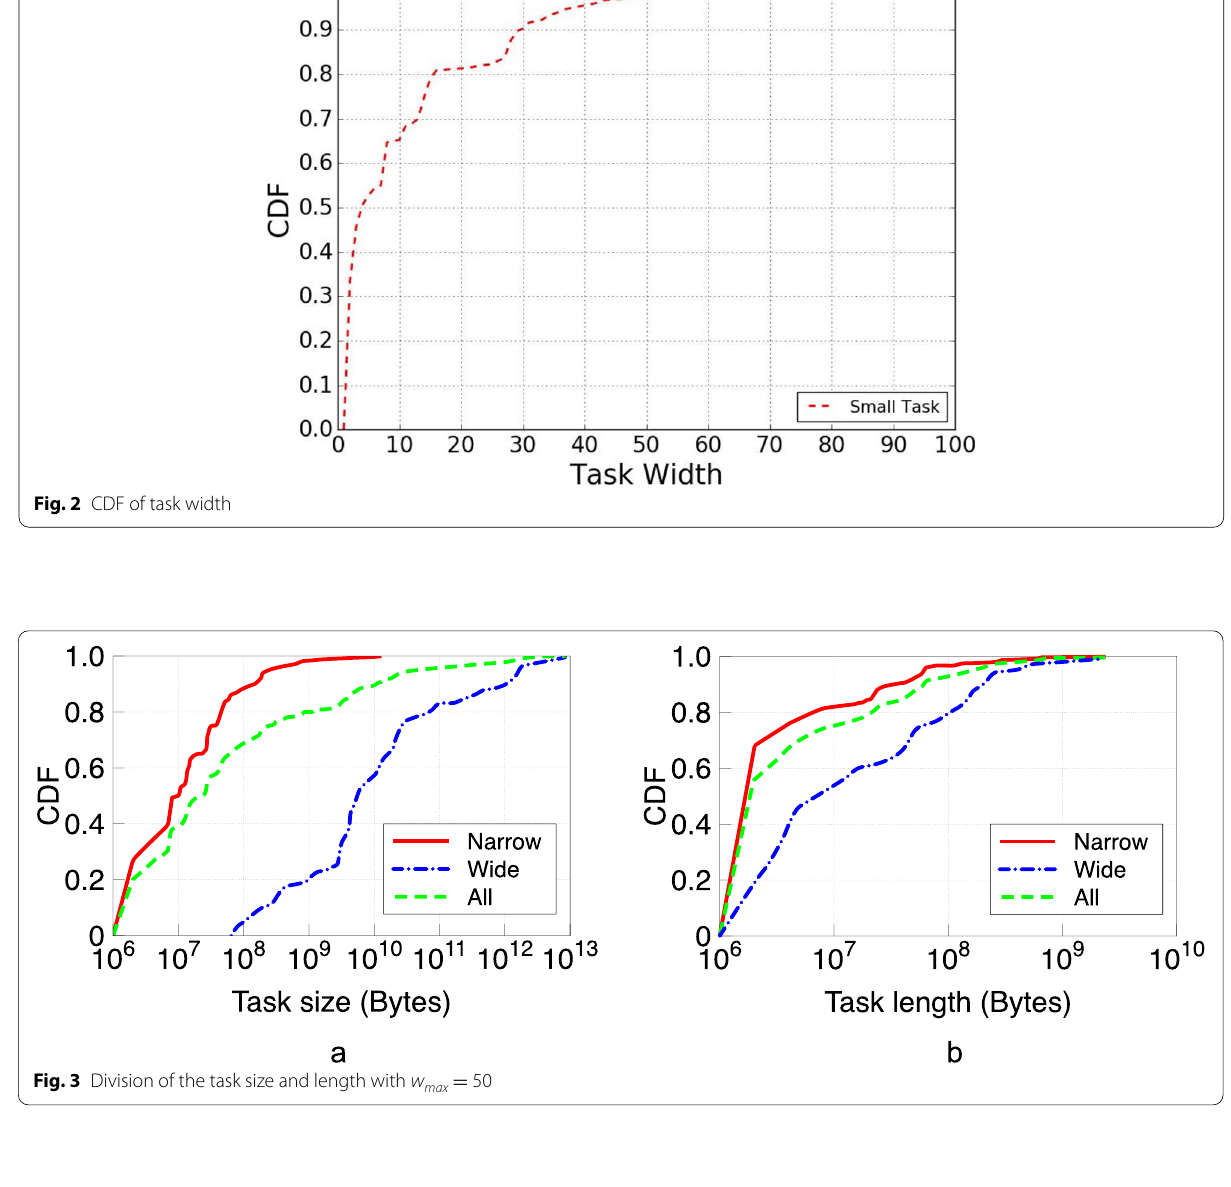
Fig. 3 Division of the task size and length with w max